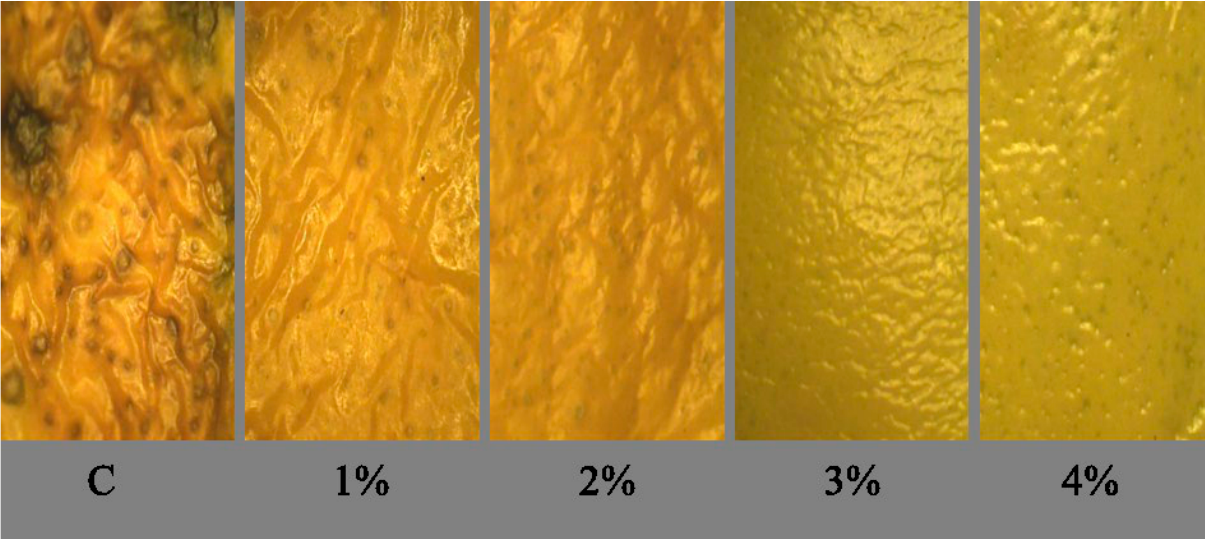
Figure 2. Electron micrographs showing details of papaya fruit epicarp texture, either uncoated or after treatment with cas- sava starch gel at different concentrations. C = Control (uncoated) and cassava starch coatings at 1%, 2%, 3% and 4% at 14 d after inoculation with Colletotrichum gloeosporioides .